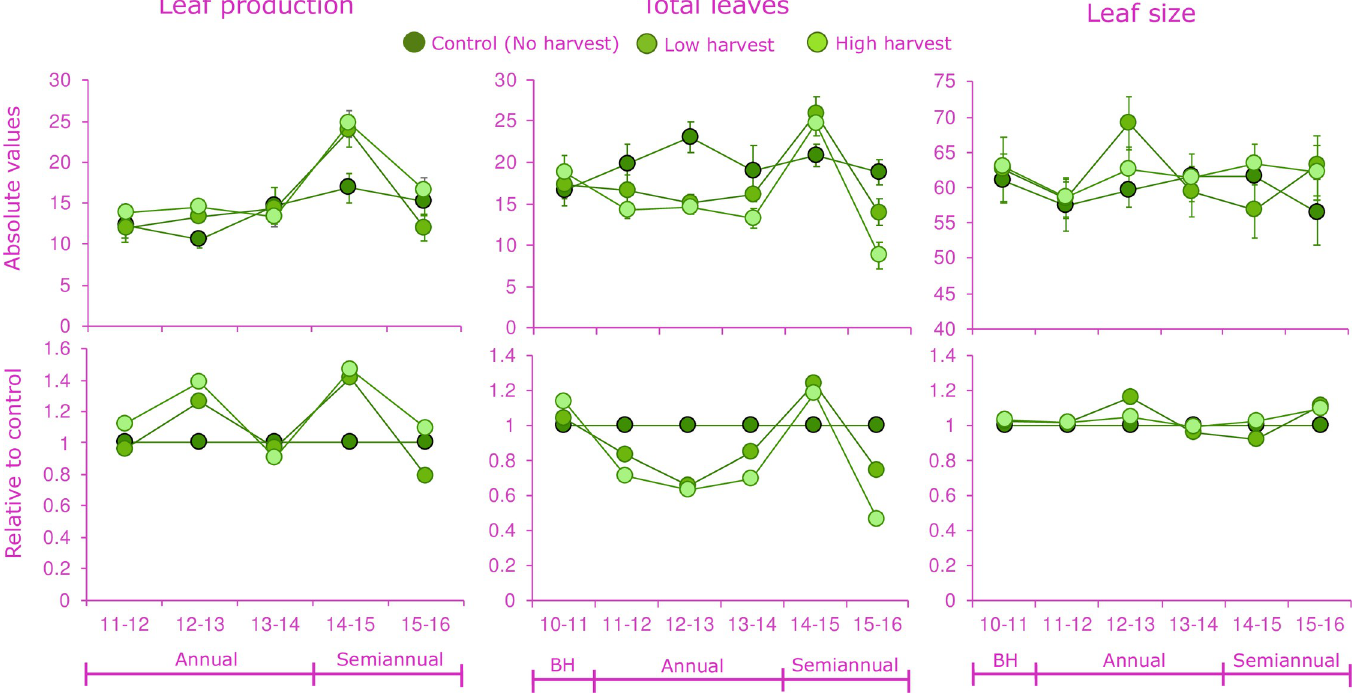
Fig 1. Variation in leaf traits of the Brahea aculeata under different experimental leaf harvest treatments in the tropical dry forest of A´lamos, Sonora: Leaf production rate (leaves ind-1 yr-1), total leaves (leaves ind-1) and leaf length (cm). Top charts indicated the absolute values, while bottom charts indicated the proportional change compared to the control treatment for each year. At the bottom charts, the no harvest treatment (Control) is used as a reference.